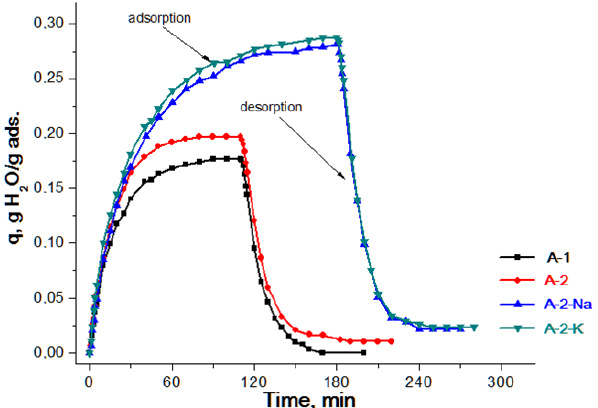
Figure 3. Kinetic curves of the adsorption and desorption of water vapor on aluminum oxide samples for a fraction of 0.5–1.0 mm (conditions: carrier gas adsorption rate at 30 L/h, desorption at 10 L/h).